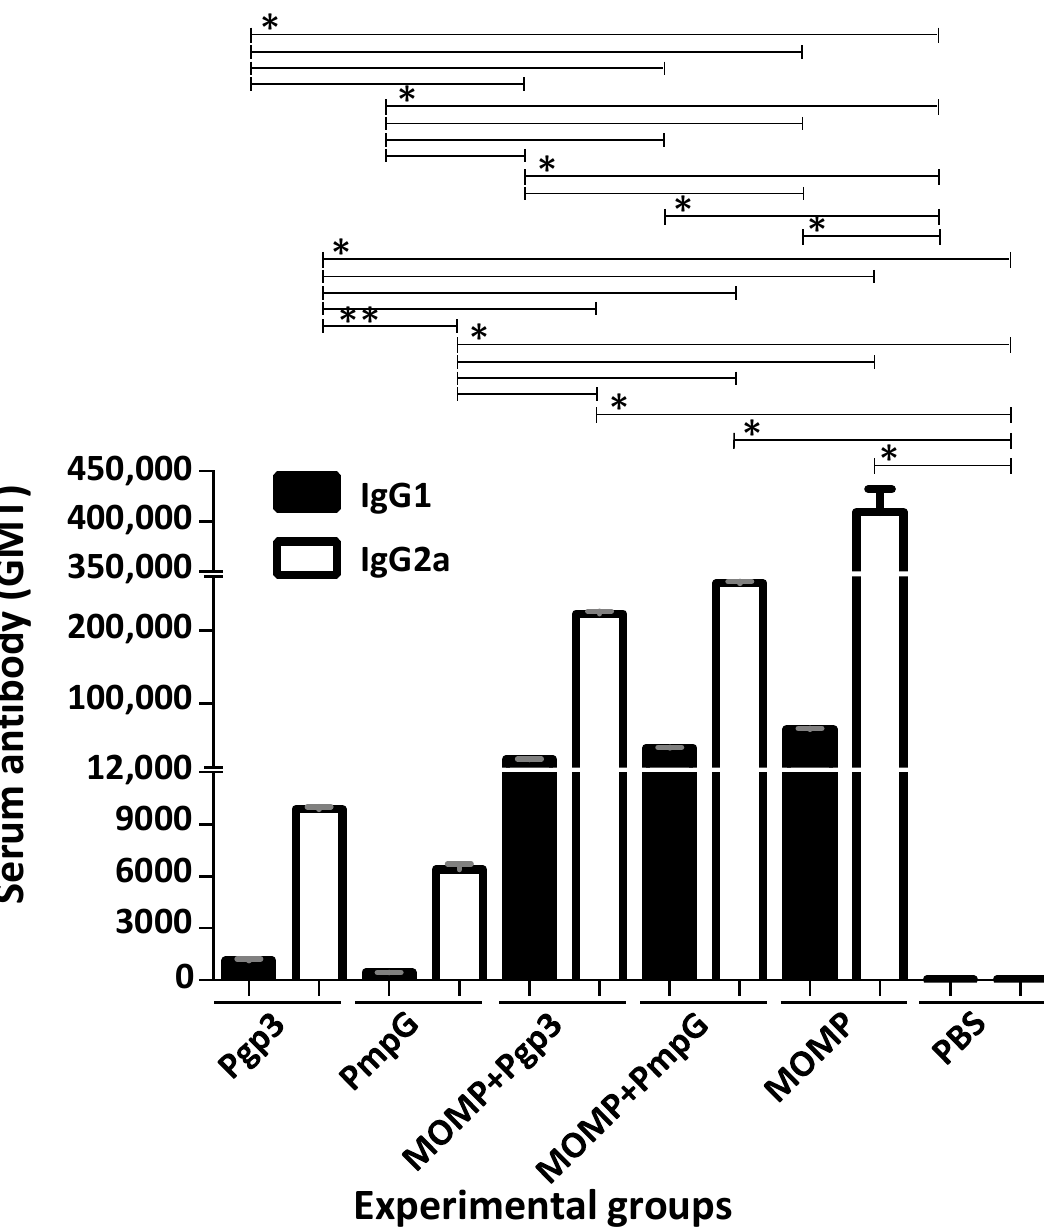
Figure 2. Vaccine-induced serum IgG1 and IgG2a antibody responses (GMT ± SE) against C. muri- darum EB the day before the i.n. challenge. Serum samples from immunized mice were collected the day before the i.n. challenge with C. muridarum and the titers of IgG2a and IgG1 determined to evaluate the Th1 versus Th2 humoral immune responses using EB as the antigen in an ELISA. BLD < 100. * p < 0.05 by the Mann–Whitney’s U -test. ** p < 0.1 by the Mann–Whitney’s U